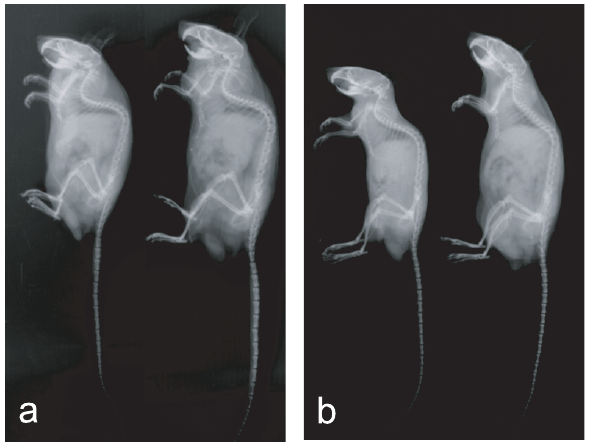
Figure 3. Radiographic analysis of 6 month old male TrkB mutant and control littermate (A), and p38 a mutant and control littermate (B). Exaggerated kyphosis is post-mortem.